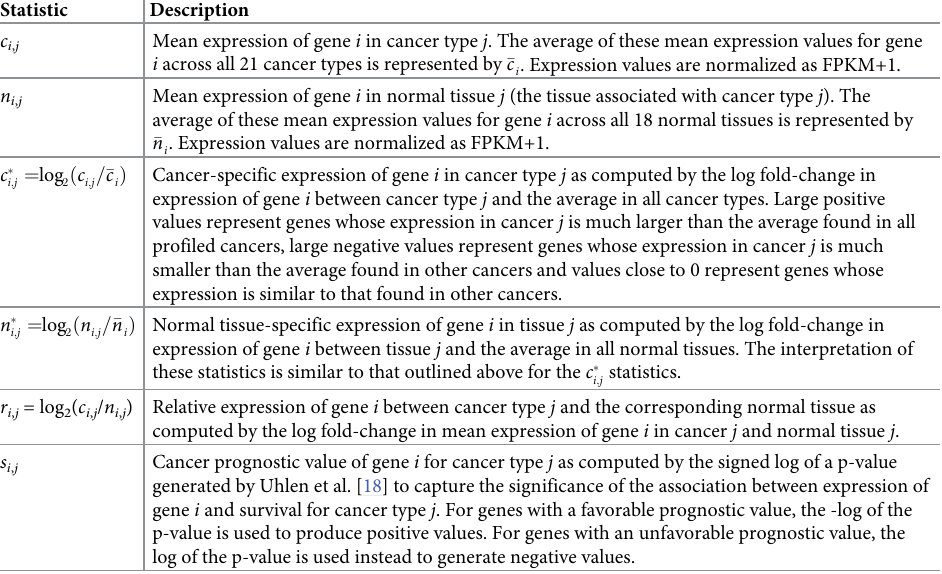
Table 2. Gene-level statistics computed on TCGA and HPA RNA-seq gene expression data and TCGA survival data. Statistic Description c i , j